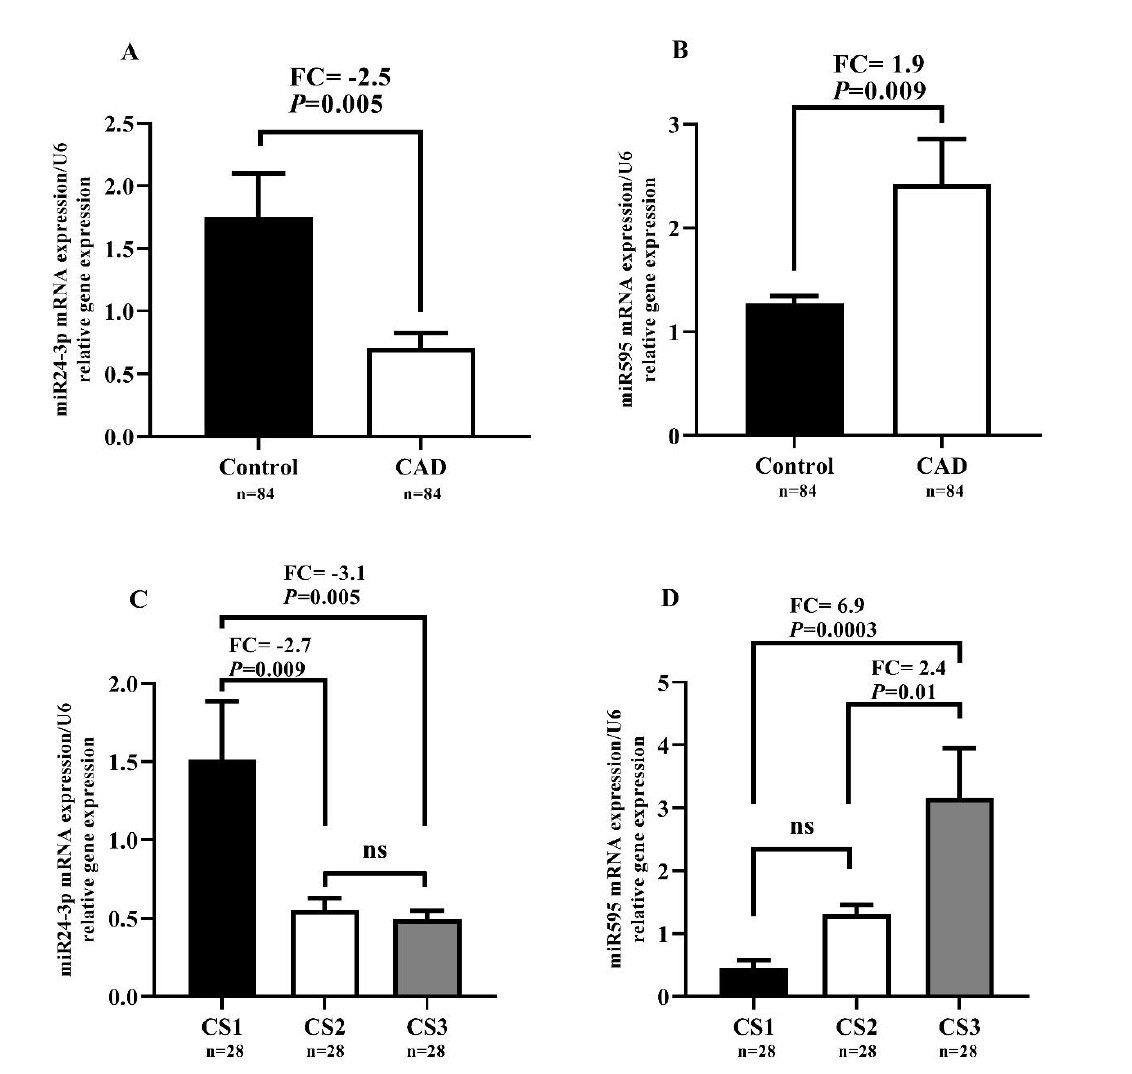
Figure 3: Relative expression levels of miR-24-3p and miR-595 in PBMCs of the participants and their relation with the number of clogged arteries. P -values ≤0.05 were considered as significant using independent-samples t-test, one-way ANOVA test (Tukey post hoc test) multiple comparison anal- ysis. Results are expressed as the mean ±